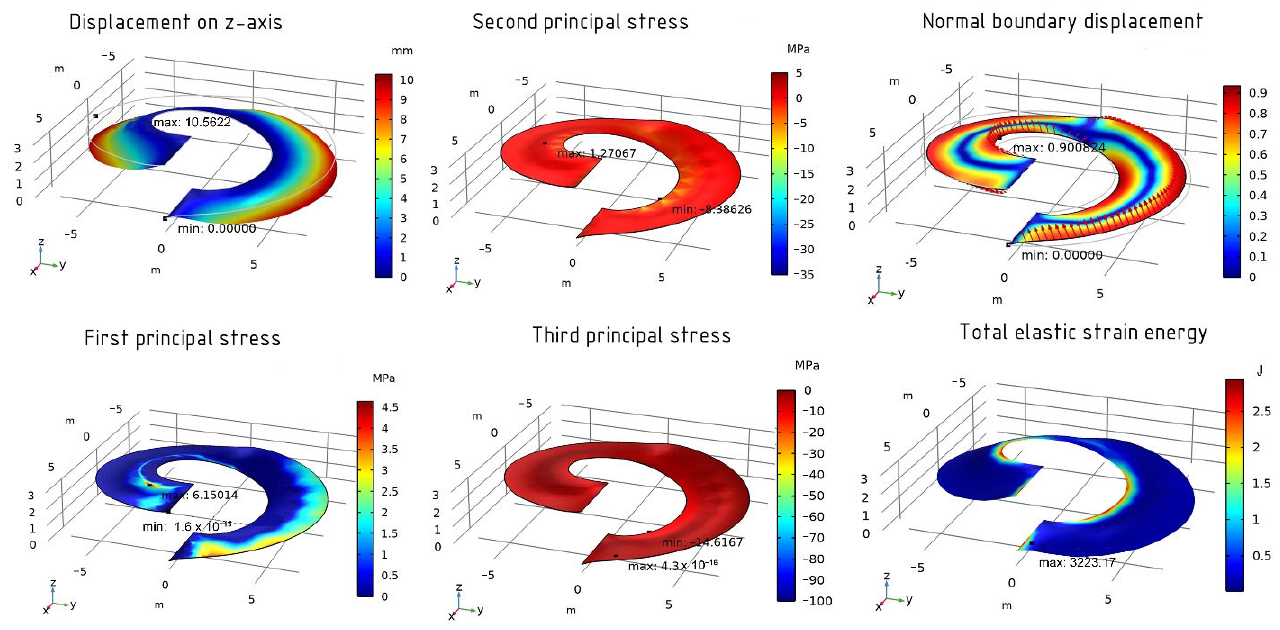
Figure 22. The results of the optimized shell using the IPOPT method.